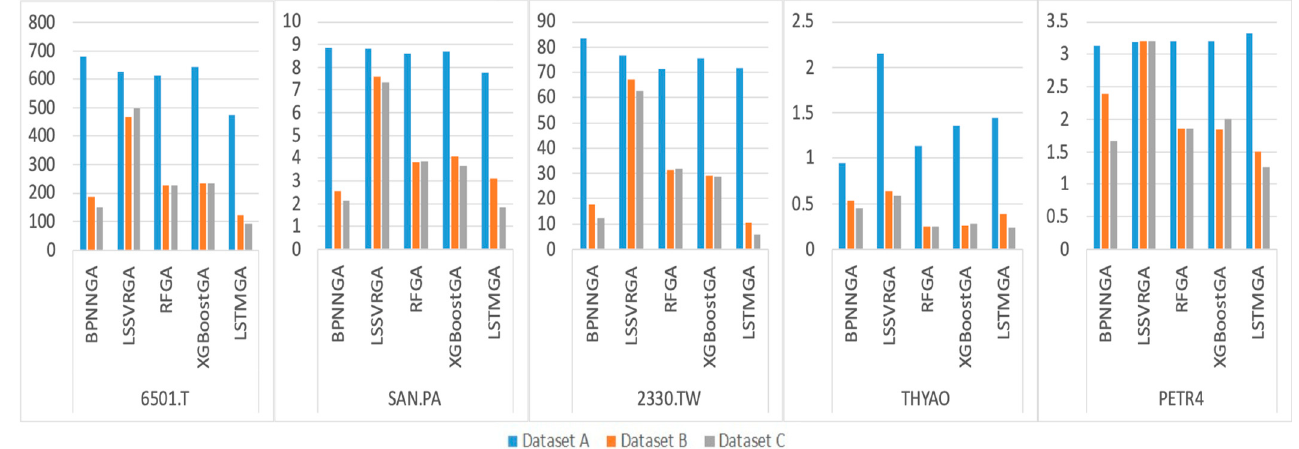
Figure 7. RMSE values of forecasting models for corporations’ stock prices with different datasets. Table 9. MAPE and RMSE values for forecasting models with three datasets.